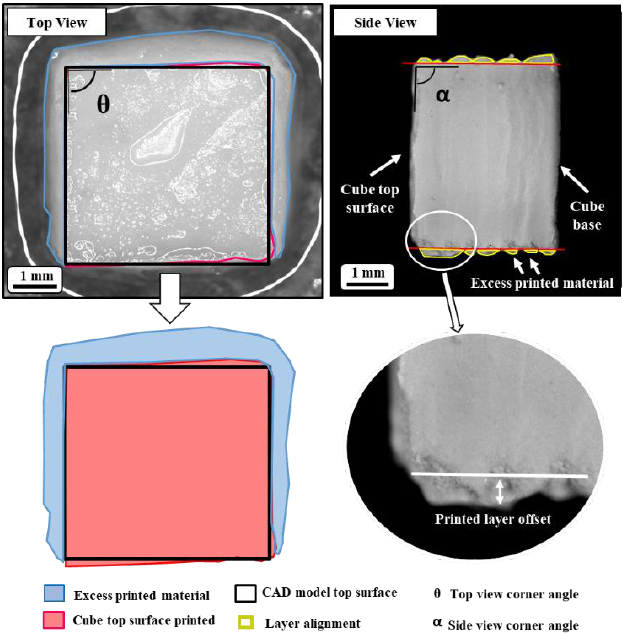
Figure 3. Printed cube top and side view, 5 mm × 5 mm cube, 40 layers.